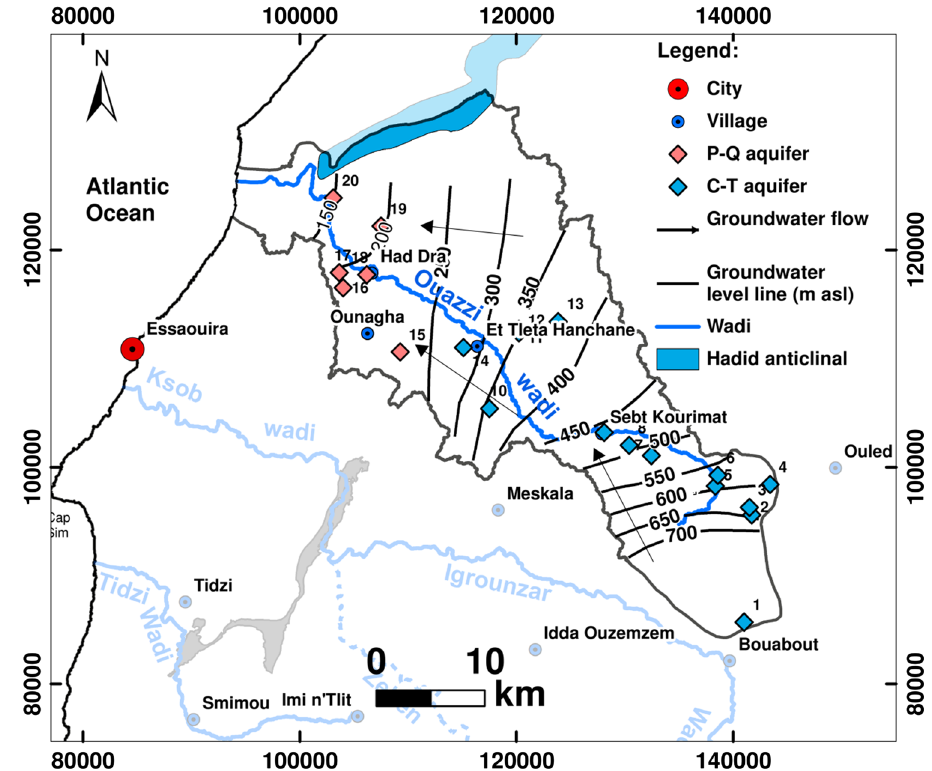
Fig. 2 Sample location and piezometric